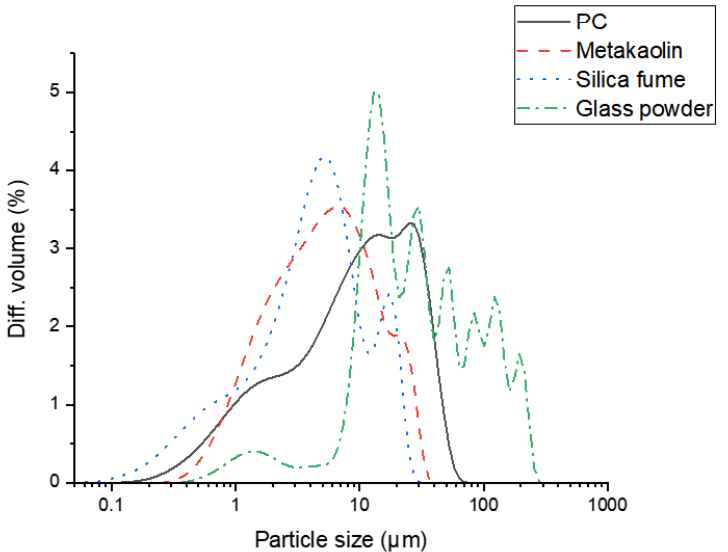
Figure 2. Particle size distributions of raw materials obtained by laser diffraction. Table 3. Chemical composition of seawater.